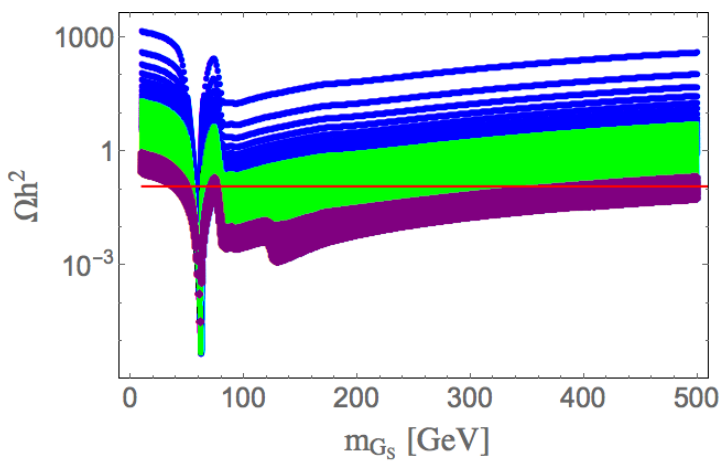
Figure 3 . DM relic density as a function of the DM mass for the case of 15 degenerate pNBGs with tan (cid:12) = 10. The coupling (cid:21) is varied between 0 : 01 (cid:0) 0 : 25 (blue), 0 : 25 (cid:0) 0 : 5 (green) and 0 : 5 (cid:0) 1 : 0 (purple); the horizontal band shows the correct density by PLANCK. For the scan, we chose: (cid:11) = (cid:12) + (cid:25)= 2.